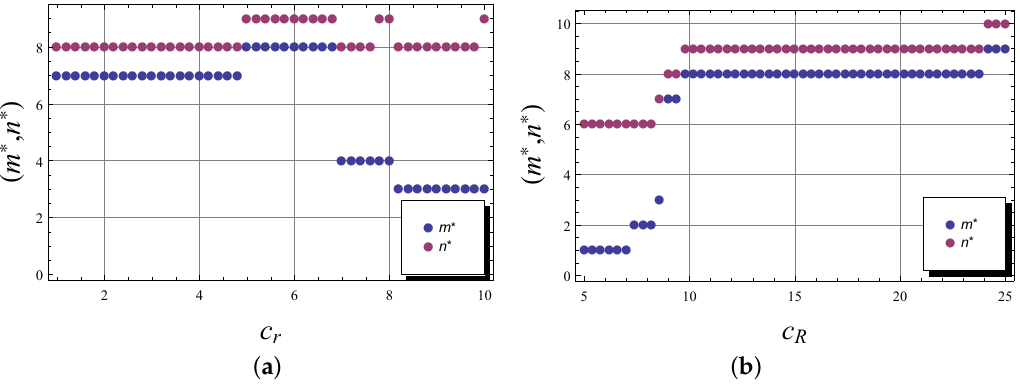
Figure 5. ( m ∗ , n ∗ ) versus c r ( a ) and c R ( b ) for the model with an instantaneous failure.